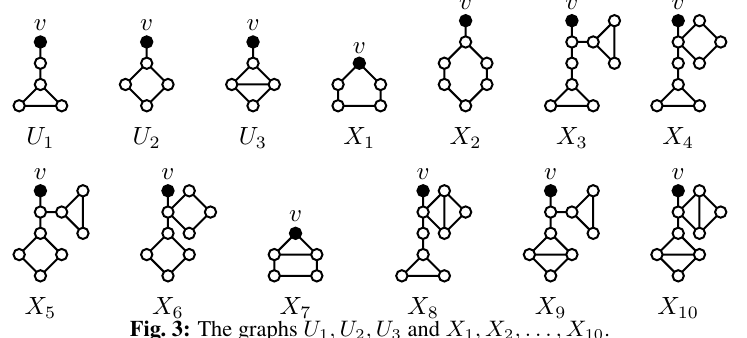
Fig. 3: The graphs U 1 , U 2 , U 3 and X 1 , X 2 , . . . , X 10